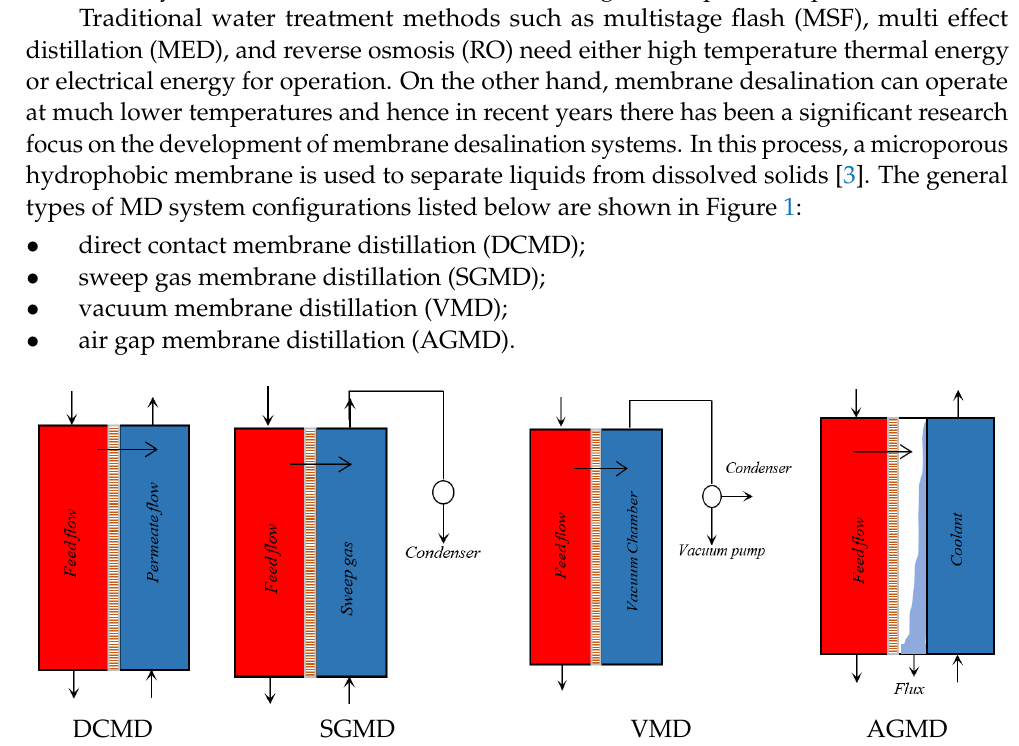
Figure 1. Schematic of different types of membrane desalination systems.